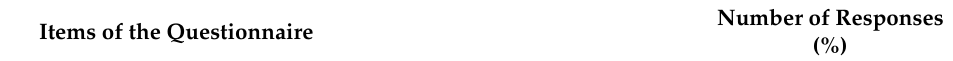
Table 2. Surgeons’ opinions regarding clinical practice and individual case